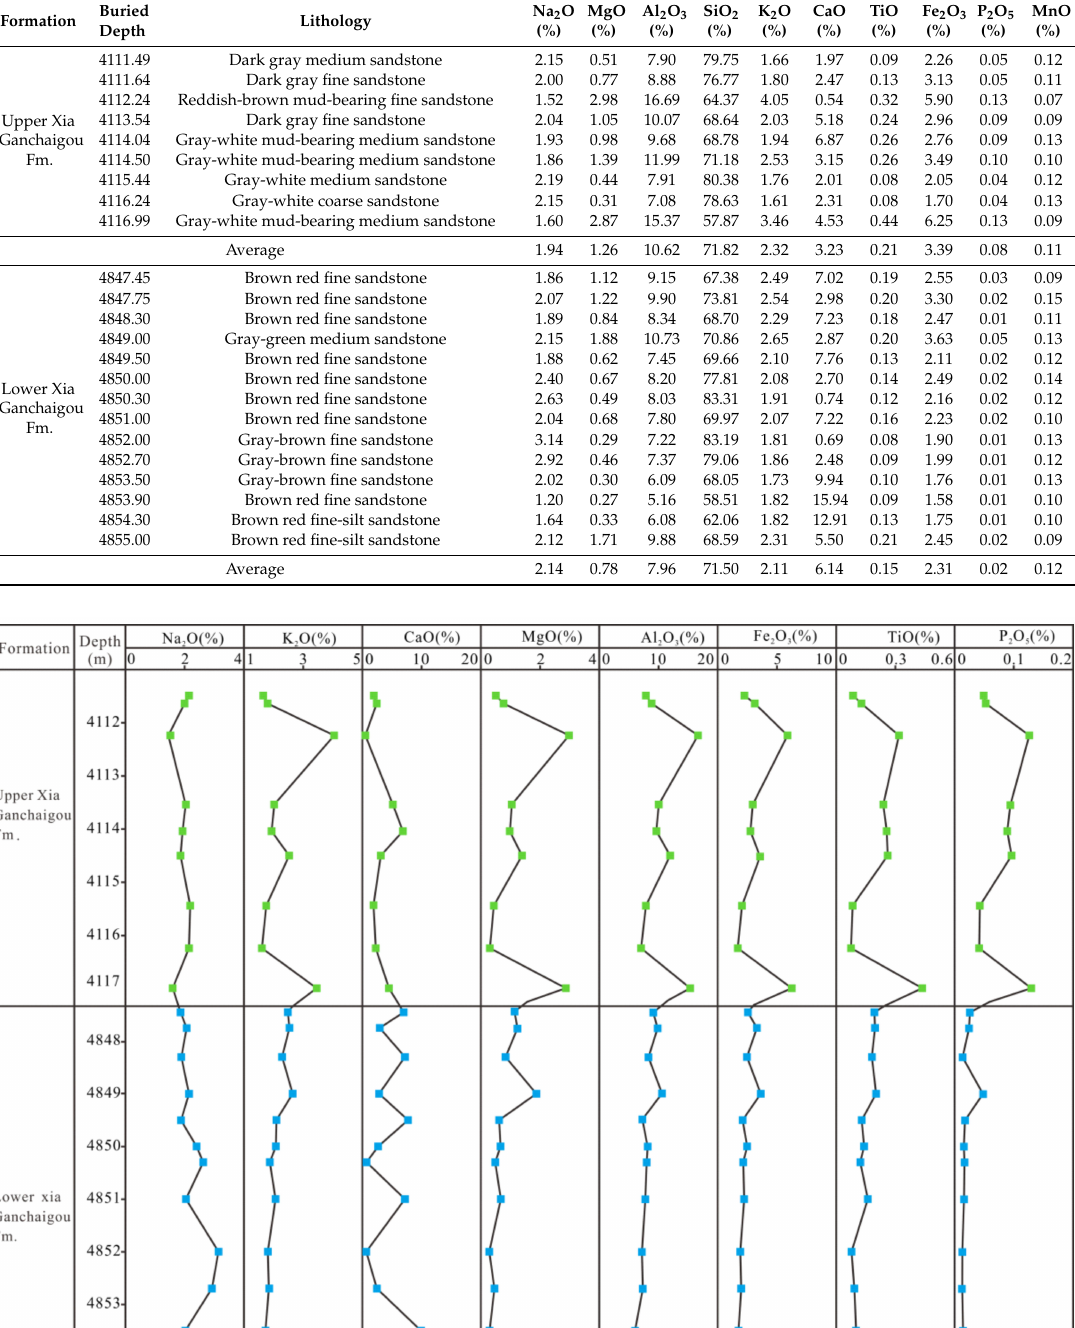
Figure 4. Major oxide content of the Xiaganchaigou Formation in the Lenghuqi structural